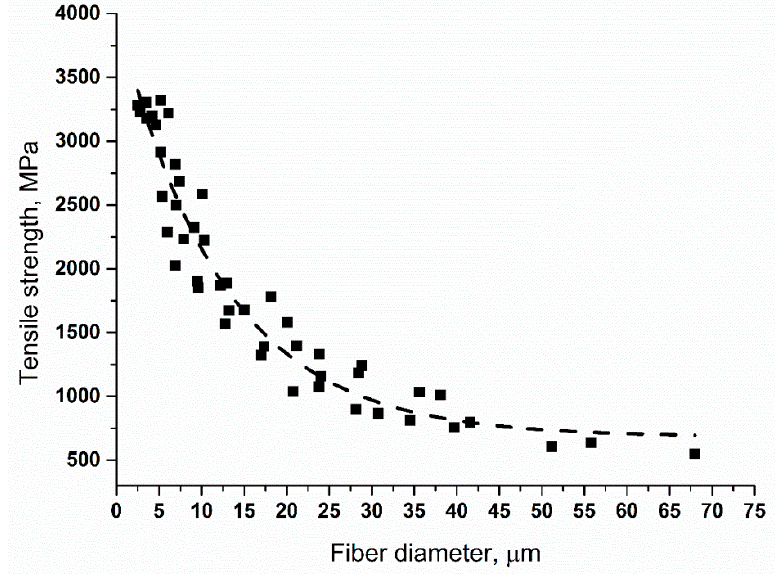
Figure 5. The dependence of basalt fiber tensile strength on their diameter.